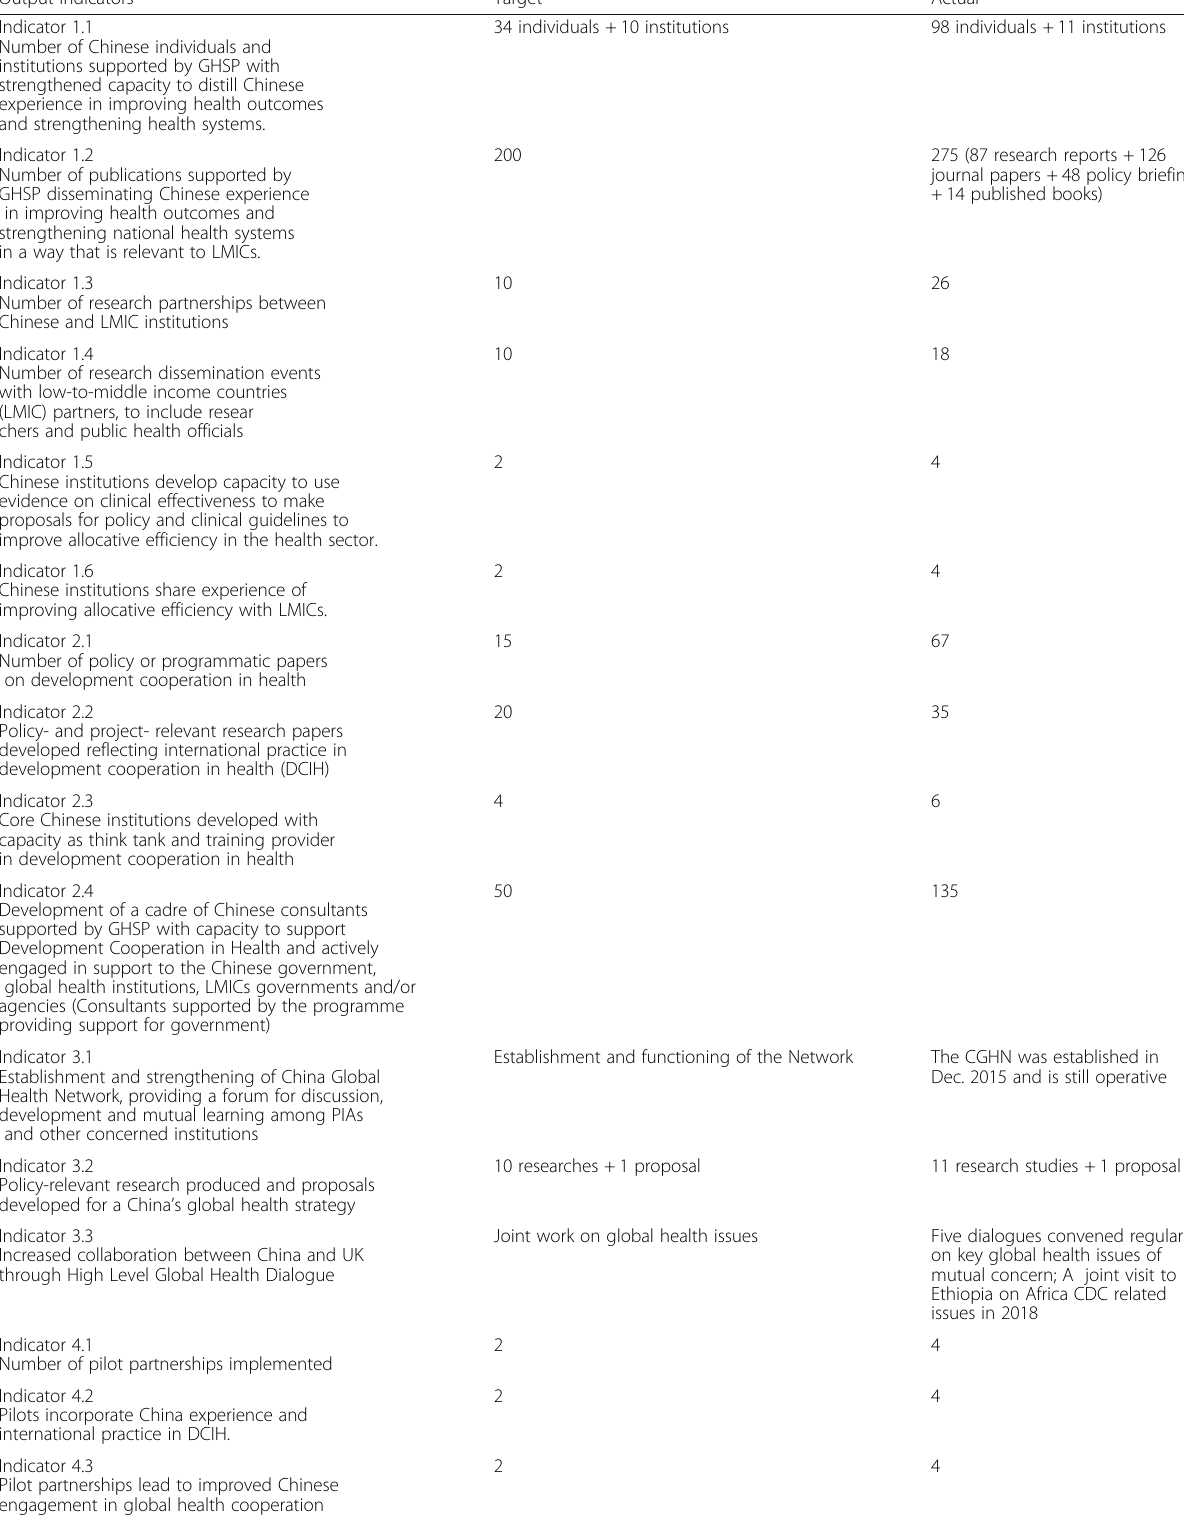
Table 2 GHSP logic framework indicators